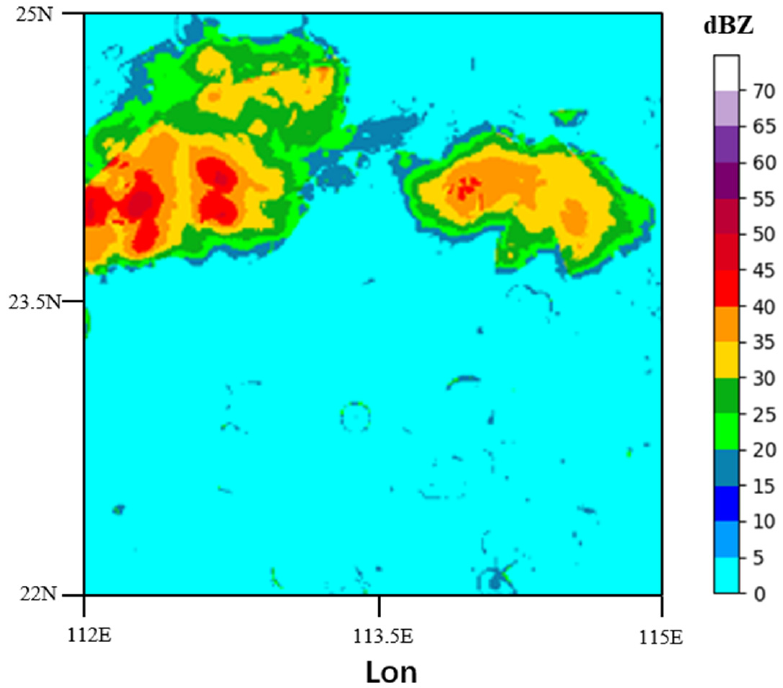
Figure 8. Predicted radar echo image with the 2S-STRef method at the lead time: 12 min. The radar echo images are of Southern China (around Guangzhou City) at 31 March 2019.